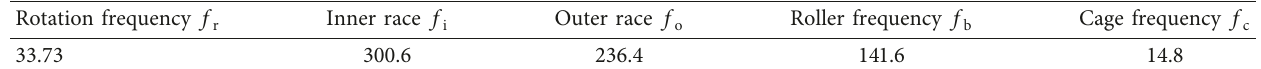
Table 6: Calculated characteristic frequencies of 6205-2RS (Hz).